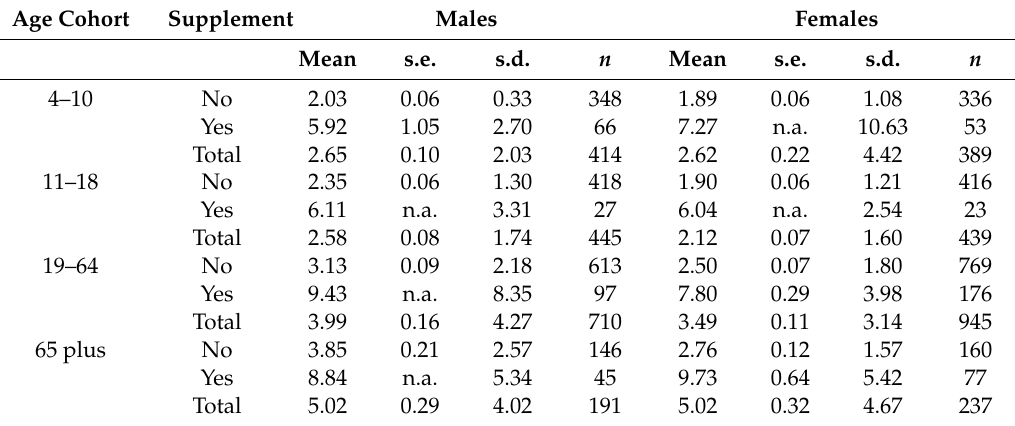
Table 1. Intake of vitamin D ( µ g / day) with or without supplementation per age cohort per gender (data from the NDNS database before application of the model). Total: all persons with and without